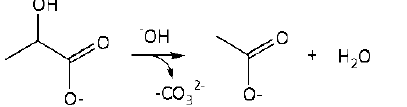
Figure 6. A schematic conversion of LA into AA in the volume.